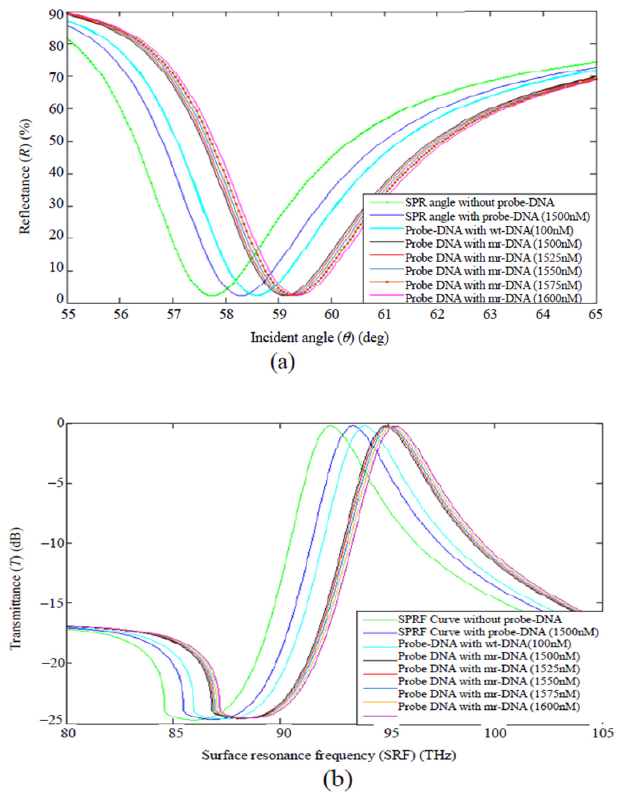
Figure 9. Change in characteristics curves for ( a ) SPR curve characteristics and ( b ) SPRF curve characteristics of the SPR sensor without pDNA, with pDNA, and with flowing different concentrated complementary target mrDNAs or mismatched target wtDNAs of BRCA1 and BRCA2 genes with PBS solutions. Reprinted with permission from Ref. [139]. Copyright 2019, Springer Nature.